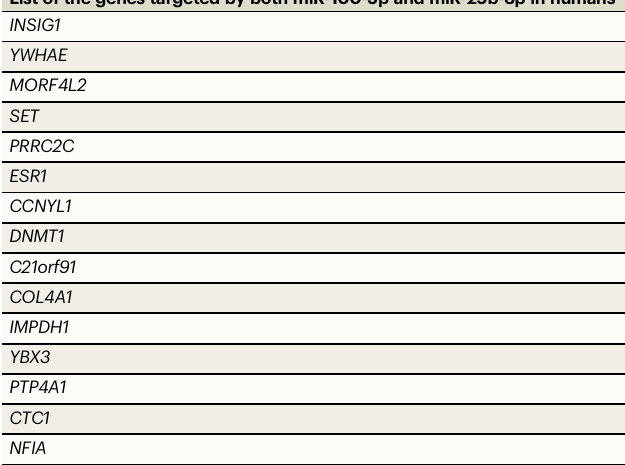
Table 2 | List of the genes targeted by both miR-29b-3p and miR-100-5p in humans List of the genes targeted by both miR-100-5p and miR-29b-3p in humans INSIG1